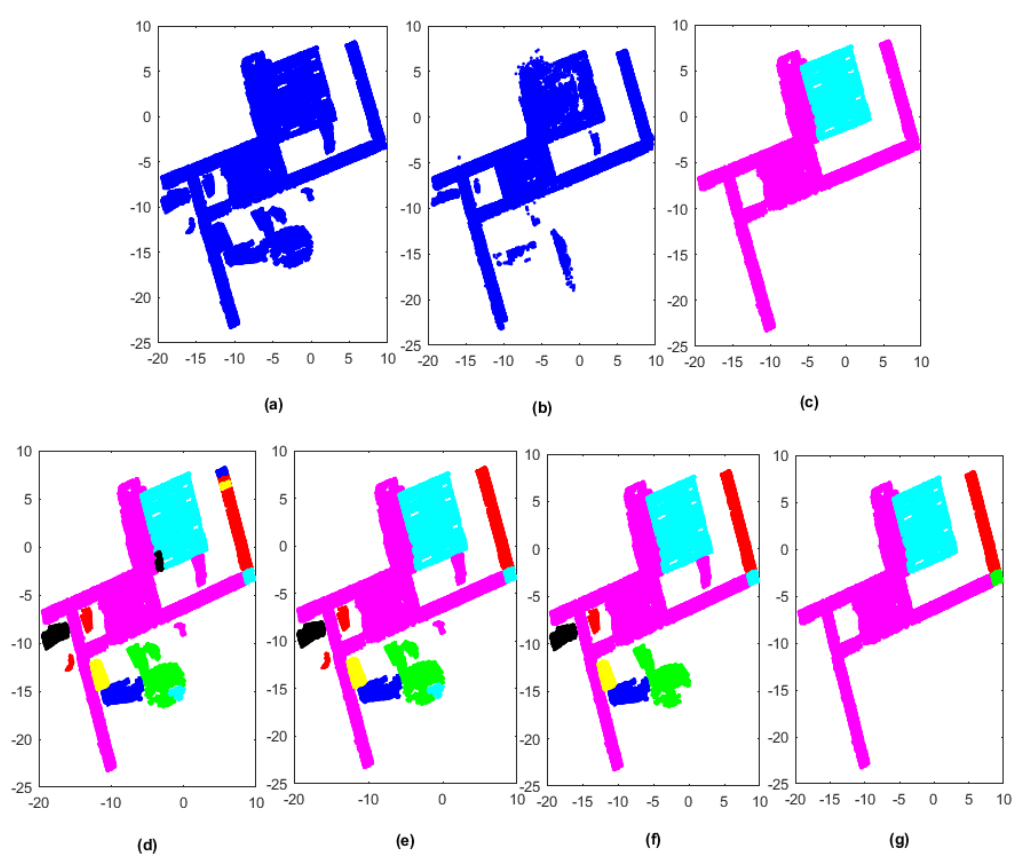
Figure 4. Clustering procedures: ( a , b ) Ceiling and floor; ( c ) results; ( d – g ) enhancement of